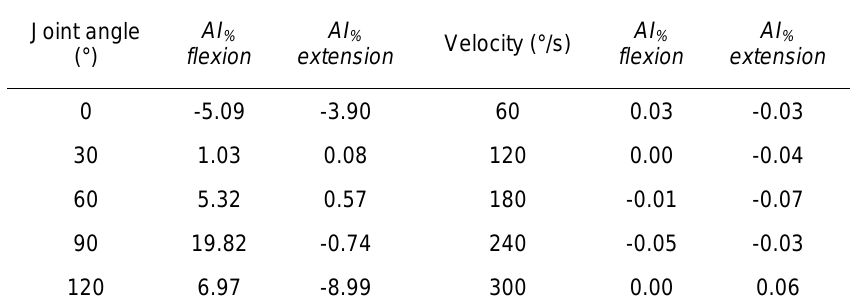
Figure 2. Torque-velocity relation for elbow flexor (top) and elbow extensor (bottom) muscles. No asymmetry was observed between the preferred (P) and non-preferred (NP) limbs. Table 1. Asymmetry index found for different joint angles and angular velocities for flexion and extension peak torque. A negative value means direction of asymmetry to the non-preferred arm. Observe the higher variability for AI obtained for the different joint angle as opposed to the almost non-variant AI obtained for the different angular